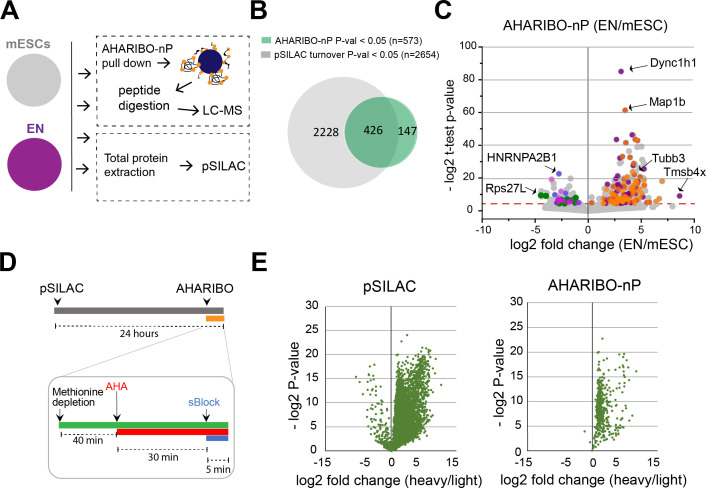
AHARIBO-nP and pSILAC.(A) Workflow for parallel AHARIBo-nP and pSILAC. mESCs: mouse embryonic stem cells; EN: mouse embryonic stem cells differentiated in early neurons. (B) Venn diagram representing the number of differentially expressed proteins (EN/mESCs) identified by AHARIBO-nP and pSILAC (p-value<0.05). (C) Volcano plot for each differentially expressed protein (EN/mESC) of AHARIBO-nP proteome versus -log2(p-value). Red broken line indicates p-value<0.05. Orange and purple dots represent upregulated proteins involved in cytoskeleton organization (GO:0007010) and neurogenesis (GO:0022008), respectively. Blue, green, and magenta dots represent downregulated proteins related to RNA processing (GO:0006396), protein synthesis (GO:0006412), and mouse pluripotency (WP1763). Gray dots represent all other proteins. (D) Schematic representation of combined cell treatments for pSILAC and AHARIBO-nP. (E) Volcano plots displaying for each protein the -log2 t-test p-value against the fold changes of protein turnover (heavy/light) in pSILAC proteome (left) and AHARIBO-nP (right) for double-treated mESCs. GO: gene ontology; AHARIBO: AHA-mediated RIBOsome isolation; pSILAC: pulsed SILAC. 
Figure 2—source data 1.A table with the pulsed SILAC (pSILAC) proteomic data.

Figure 2—source data 2.A table with AHA-mediated RIBOsome isolation (AHARIBO) differentially expressed proteins.Proteins are considered differentially expressed when adjusted p-values are smaller than 0.05 AHARIBO-nP differentially expressed proteins.